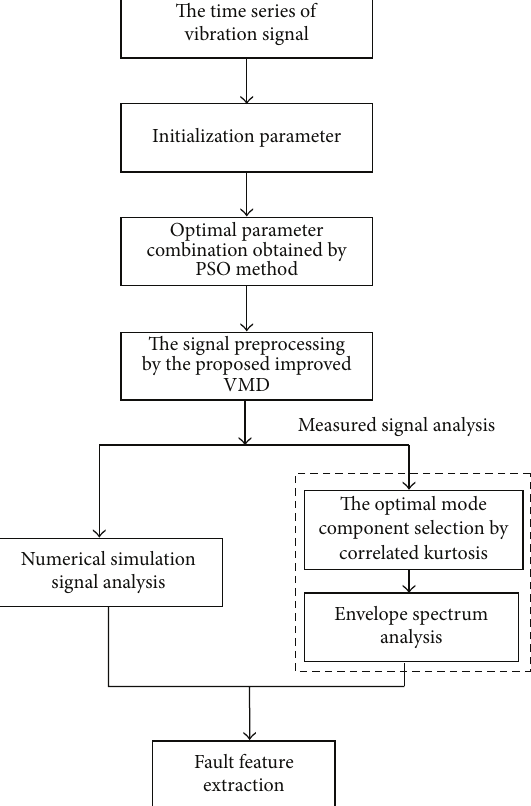
Figure 1: The flowchart about the proposed